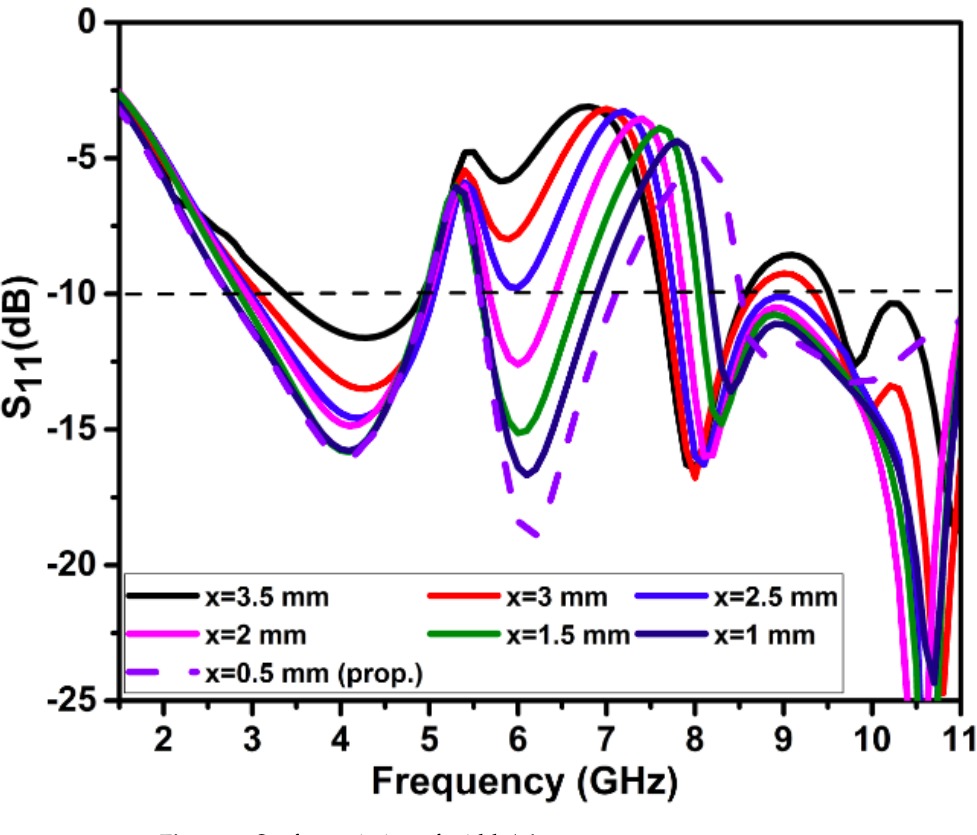
Figure 8. S 11 for variation of width ‘x’.